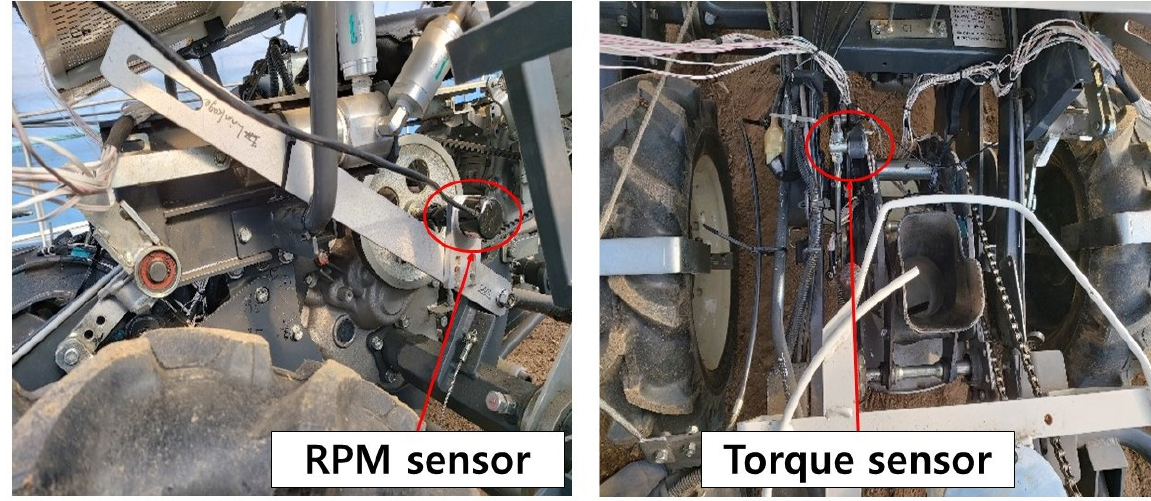
Figure 6. Location of torque and rpm sensors installed on cam vegetable transplanter.